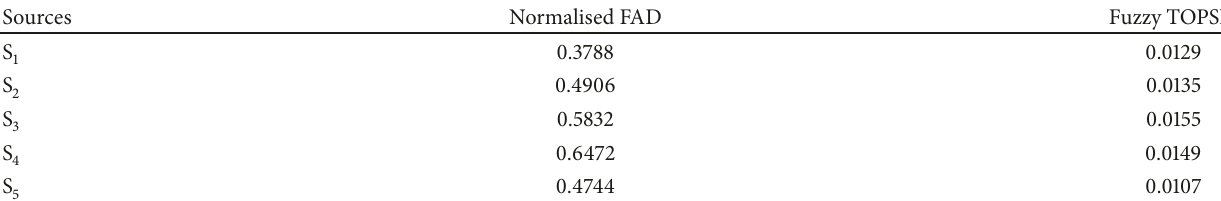
Table 21: Normalisation decision matrix for the WASPAS method.